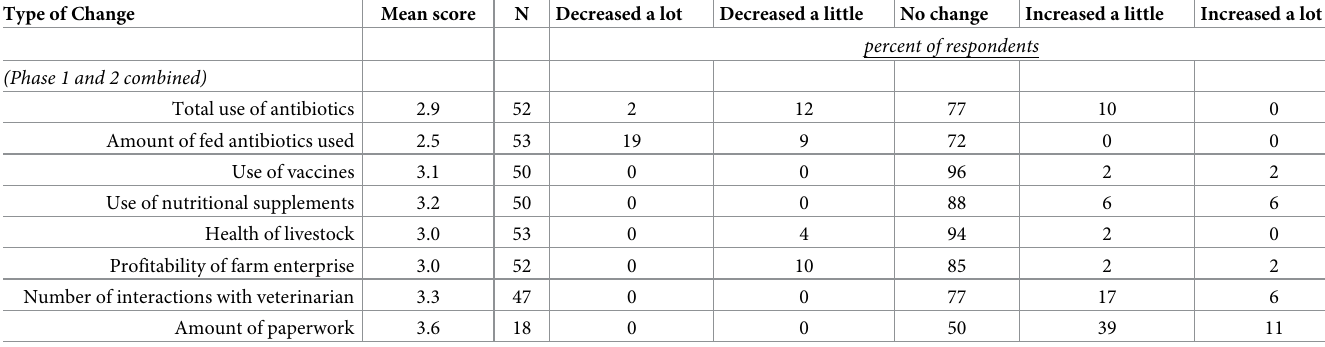
Table 2. Changes due to VFD reported by interviewed Ohio cattle